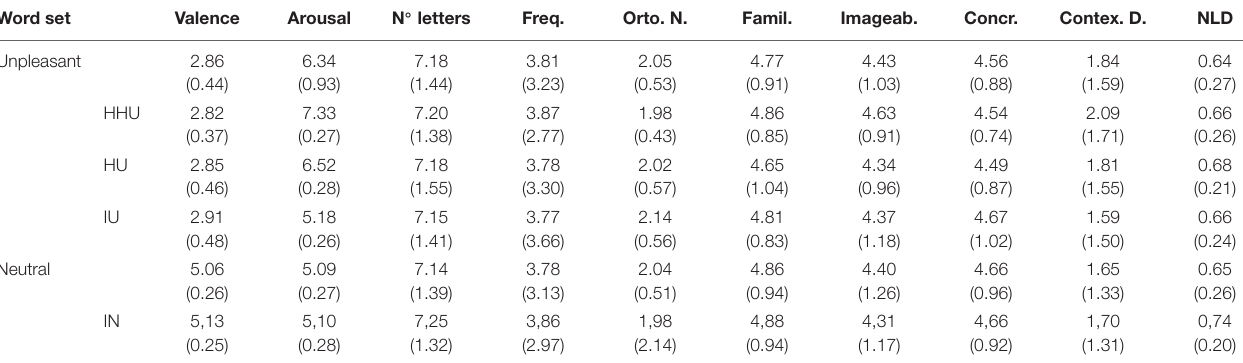
TABLE 1 | Mean and standard deviation values for each set of words in all controlled and manipulated variables. Word set Valence Arousal N ◦ letters Freq. Orto. N. Famil. Imageab. Concr. Contex. D.